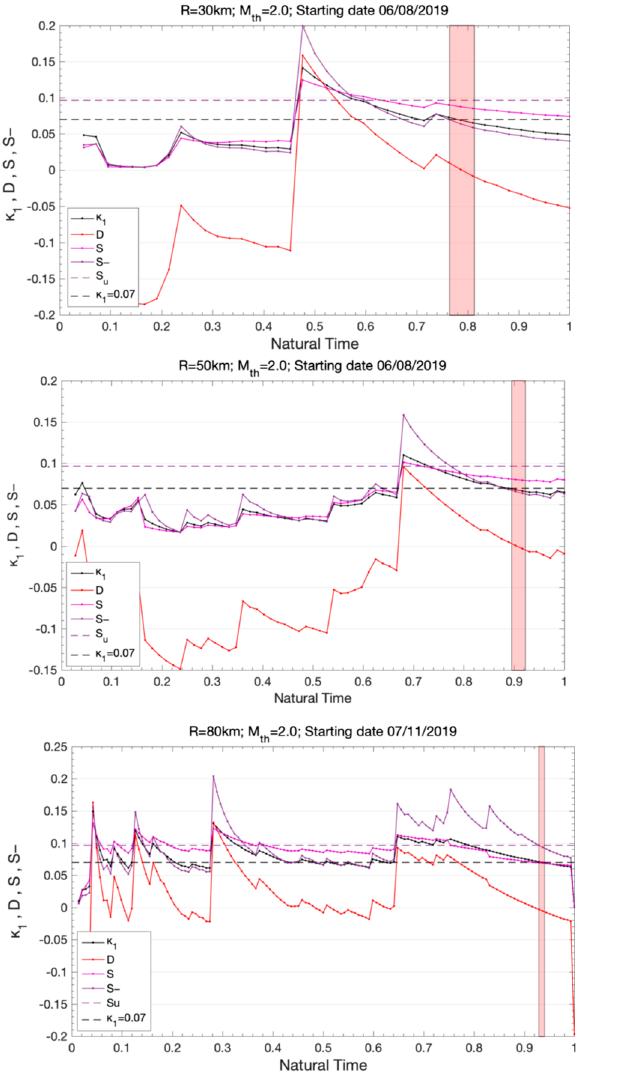
Figure 7. Time evolution of Π ( ϕ ), for 0 ≤ ϕ ≤ 0.5, of the seismic activity, for M th ≥ 2.0 and R = 30 km ( top ), R = 50 km ( middle ), and R = 80 km ( bottom ), when calculations start on 06/08/2019 for R = 30 km and R = 50 km and on 07/11/2019 for R = 80 km. Π ( ϕ ) curves (dashed lines) fall on the theoretical Π ( ϕ ) curve (red solid lines), calculated from Equation (6), as the critical stage is approached.